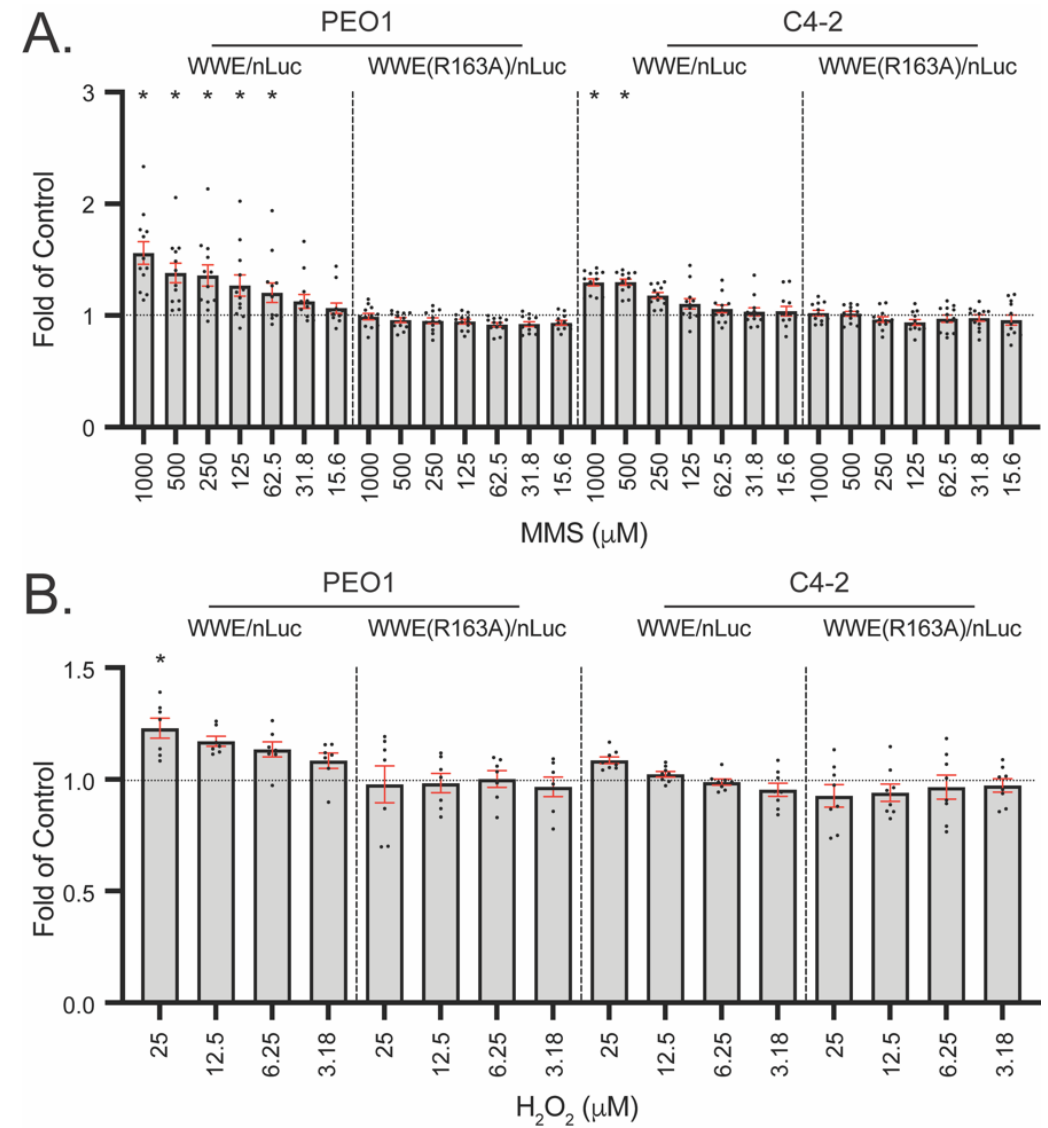
Figure 6. Enhanced PARylation in BRCA2-deficient cells identified using the WWE split luciferase assay. WWE-nLuc [or WWE(R163A)-nLuc] and WWE-cLuc were expressed in BRCA2-deficient PEO1 or BRCA2-resurgent C4-2 cells using a single lentiviral vector. ( A ) PAR formation following 30